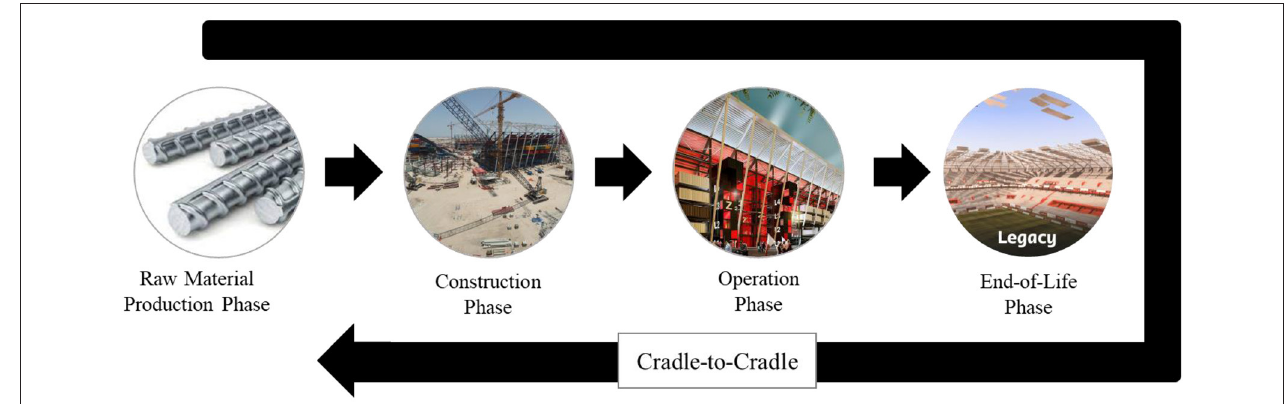
FIGURE 2 | Life cycle stages considered in the RAA case